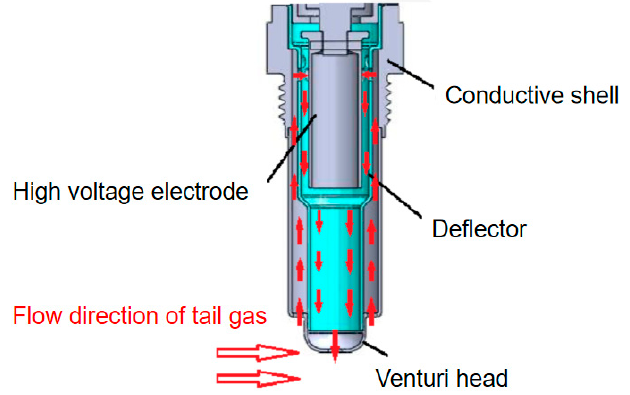
Figure 1. Structure of leakage current particulate matter sensor.